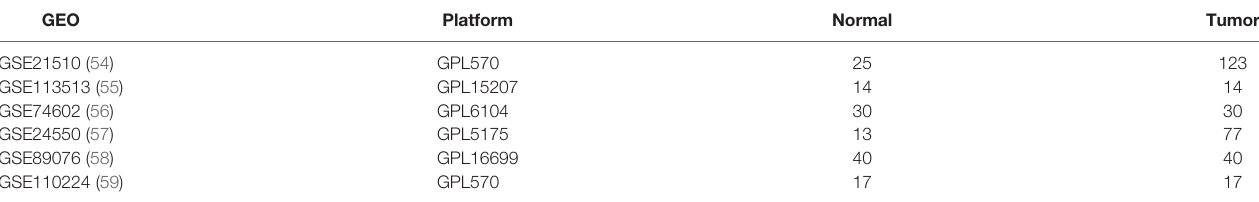
TABLE 1 | Information of six gene datasets in the GEO database. GEO